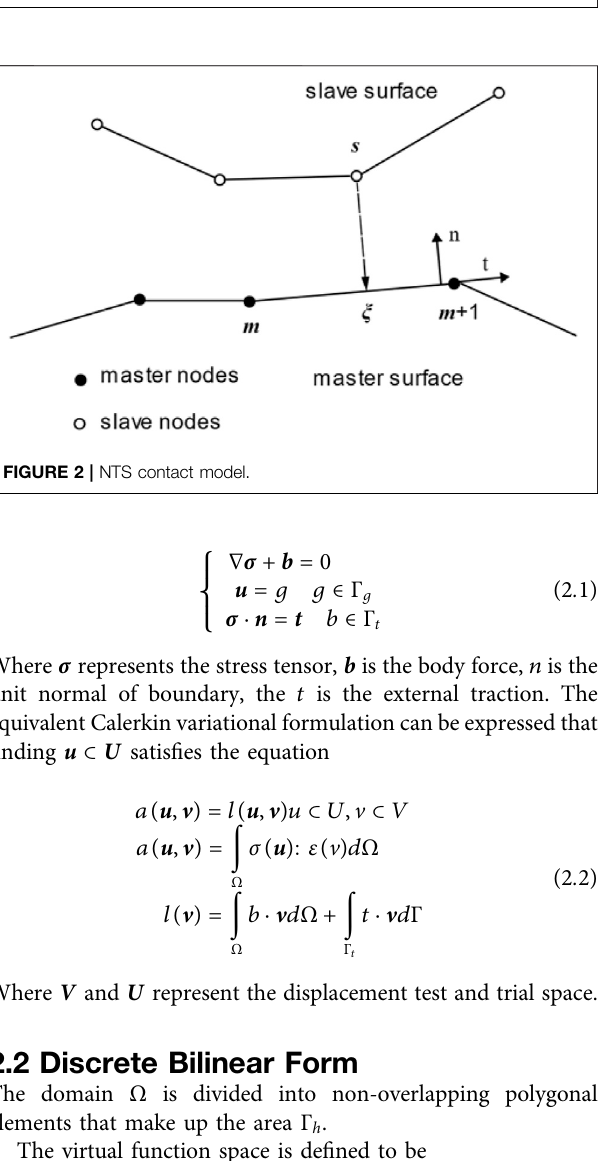
FIGURE 1 | Contact problem description.